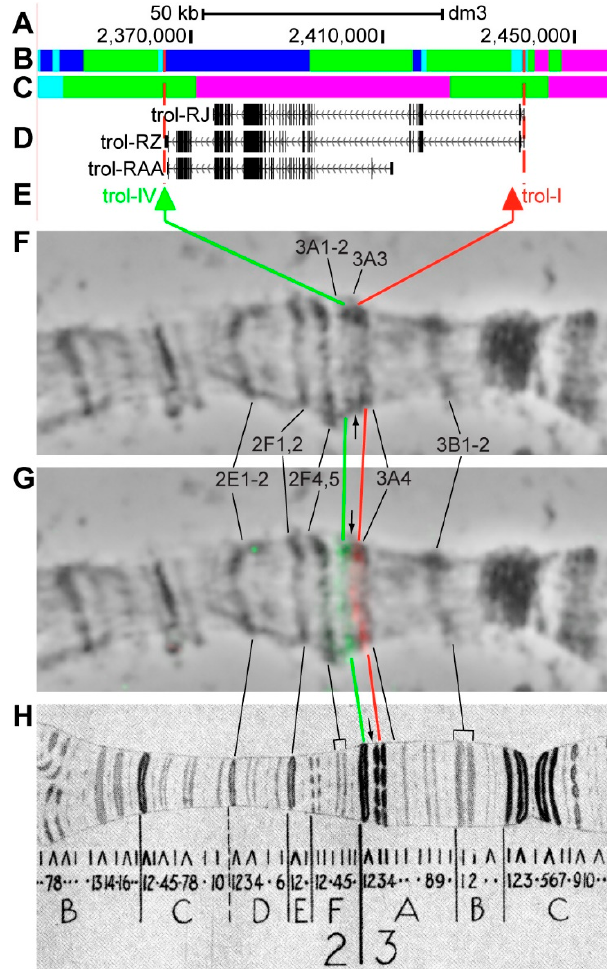
Figure 10. Localization of the trol gene in the 3A1-4 region (the gene is bound by red dotted lines). ( A ) the scale (kb) and genomic coordinates (bp); ( B ) the four chromatin-state model [39]; ( C ) the chromatin condensation level model [32]; ( D ) genes location (arrow lines show the gene orientation and black bars indicate the location of gene exons); ( E ) probes location; ( F ) phase-contrast micrograph of the region; ( G ) combined FISH signals; and, ( H ) C. Bridges’ chromosome map